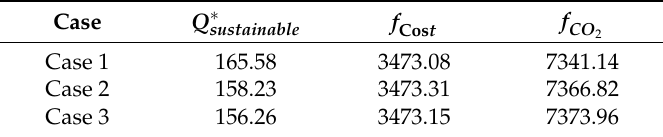
Table 6. Effect of uncertain information on optimal results.